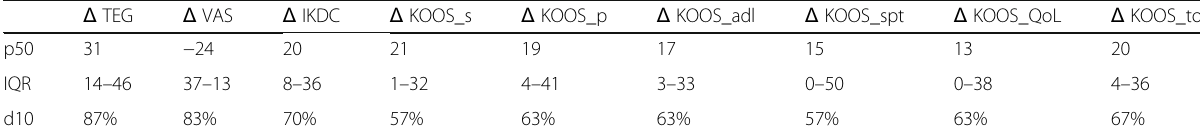
Table 2 Summary of the